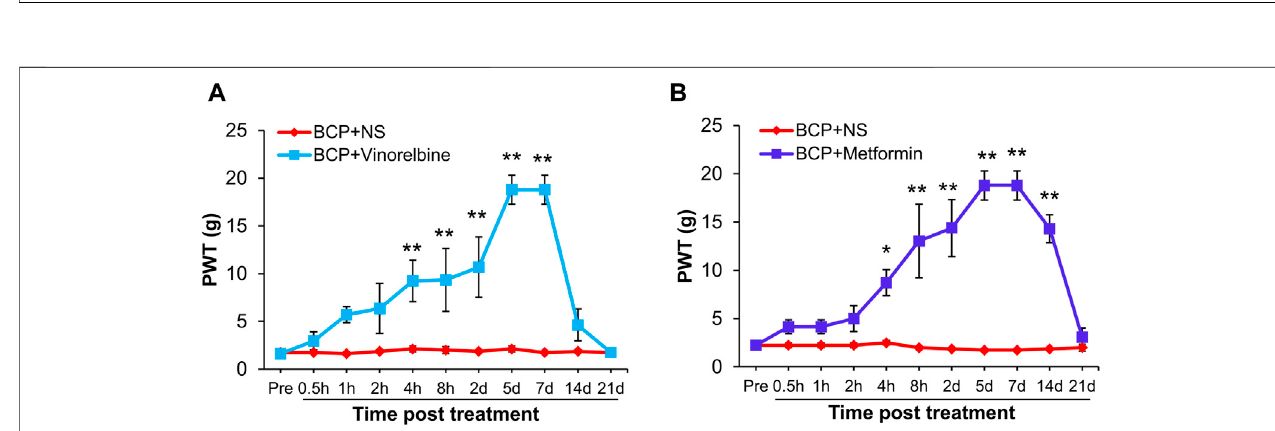
FIGURE 5 | Metformin or Vinorelbine treatment attenuated the mechanical allodynia of BCP rats. (A) The PWT of BCP rats (2 weeks after transplantation) treated with Vinorelbine (intraperitoneal injection, 3 mg/kg) was signi fi cantly increased than in age-matched BCP rats injected with same volume of NS from 4 h to 7 days (** p < 0.01 vs. BCP + NS, two-way repeated measures ANOVAfollowed bySidak ’ spost hoc test). (B) The PWT ofBCPrats (2 weeks after transplantation) treated with Metformin (intraperitoneal injection, 200 mg/kg) was signi fi cantly increased than in age-matched BCP rats injected with same volume of NS from 4 h to 14 days (* p < 0.5, ** p < 0.01 vs. BCP + NS, two-way repeated measures ANOVA followed by Sidak ’ s post hoc